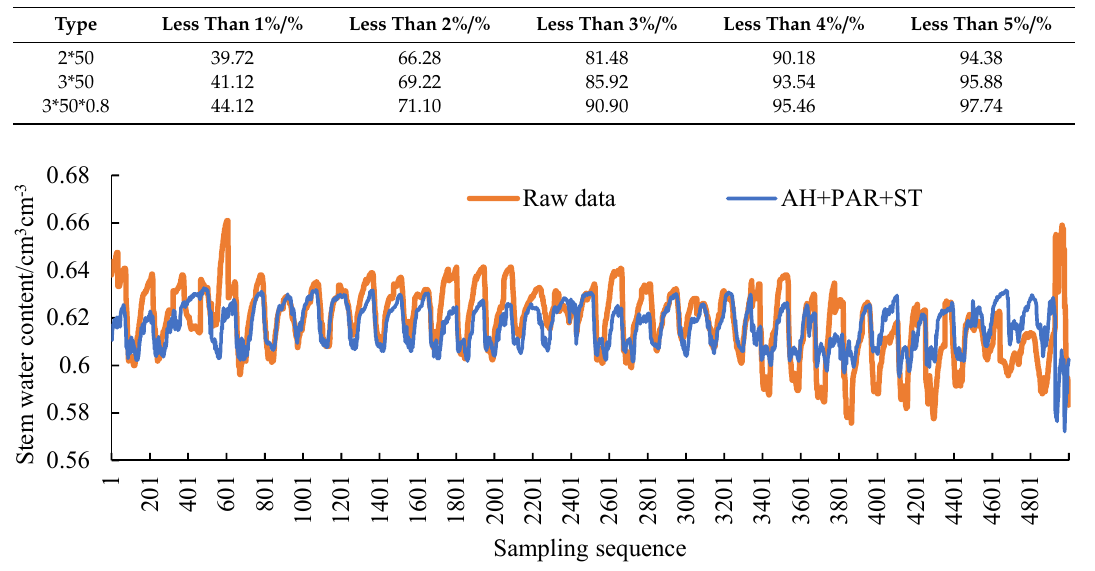
Figure 14. The comparison between the filling result of the third model with the smallest error value and the actual value.